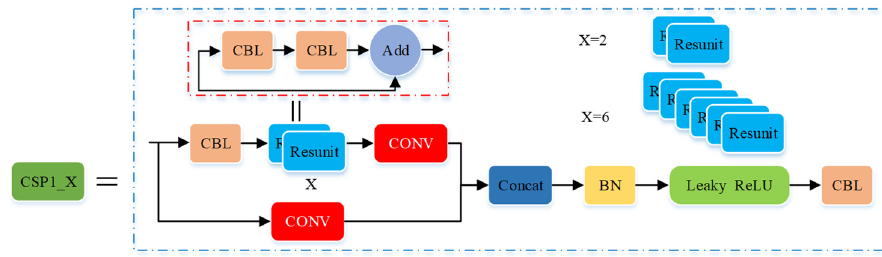
Figure 11. Structure of the CSP1_X module.